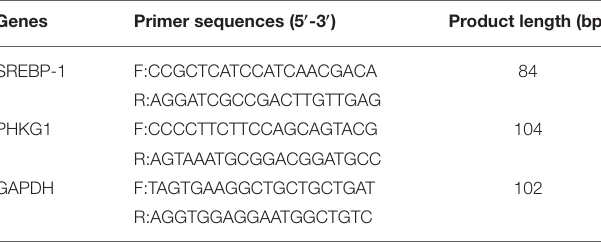
TABLE 4 | Primer sequences of lipid metabolism-related genes.